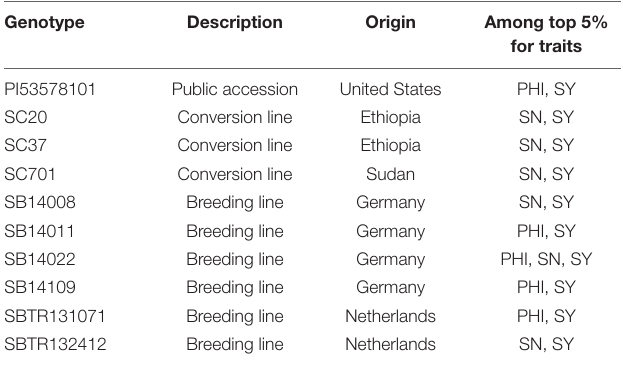
TABLE 4 | Overview of the lines ranking among the top 5% performers for more than one trait related to reproductive cold tolerance. Genotype